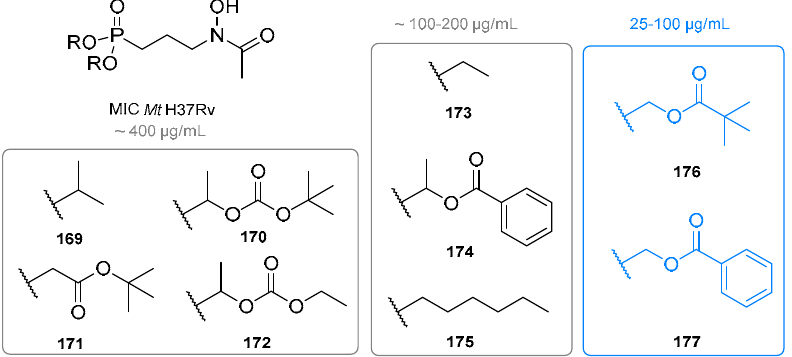
Figure 33. Inhibitory activity of different FR900098 prodrugs ( 169 – 177 ) against M. tuberculosis H37Rv in growth assay.